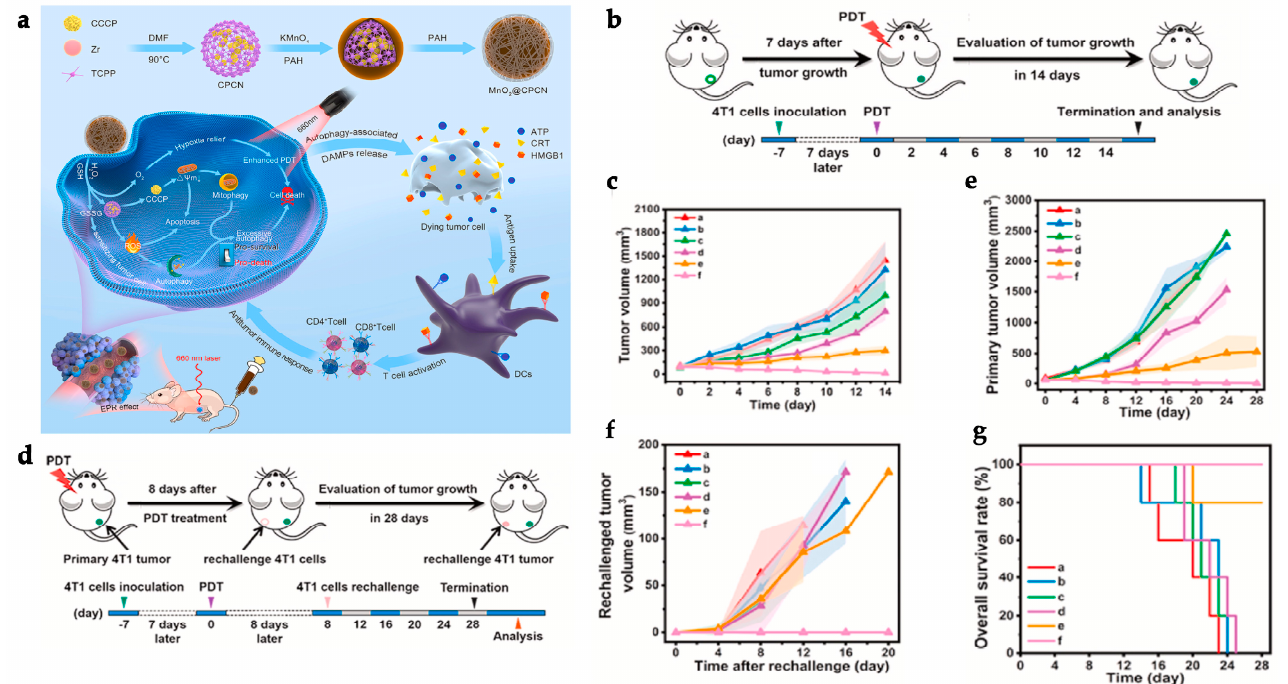
Figure 5. MOF-based synergetic PDT-immunotherapy ( a ) PCN-224 encapsulated CCCP through a solvothermal reaction and was coated by a MnO 2 shell in a redox reaction between KMnO 4 and PAH. A coating of PAH was added generating MnO 2 @CPCN. Synergy of PDT with autophagy/mitophagy pro-death function and its immunomodulating effects triggered increased immune response. ( b ) 4T1 tumor cells were inoculated in mice and grown for 7 days. Mice were treated with ( a ), PBS; ( b ), Laser; ( c ), MnO 2 @CPCN (12 mg/kg PCN equiv. and 3 mg/kg CCCP equiv.); ( d ), MnO 2 @PCN + L (12 mg/kg PCN equiv.); ( e ), CPCN + L (3 mg/kg CCCP equiv.); and ( f ), MnO 2 @CPCN + L. (12 mg/kg PCN equiv. and 3 mg/kg CCCP equiv.) and laser irradiated (660 nm, 0.2 W/cm 2 ) for 10 min. Tumor evolution was evaluated for 14 days until mice were sacrificed. ( c ) Tumor volume under different treatments. ( d ) Mice were inoculated with 4T1 tumor cells and treated after 8 days. Tumor growth was evaluated for 28 days. ( e , f ) Tumor volume variation of primary ( e ) and rechallenged tumor ( f ) after treatment. ( g ) Survival rates after different treatments. n = 5 [125]. Copyright © 2022, with permission from Elsevier.